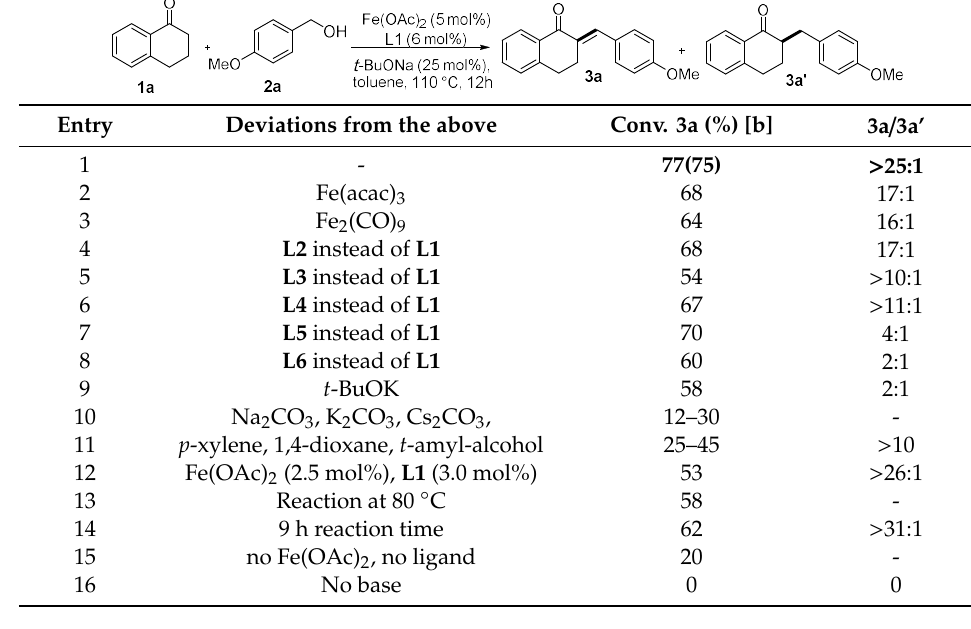
Table 1. Optimization table for Fe-catalyzed α -alkenylation of ketone [a, b, c].